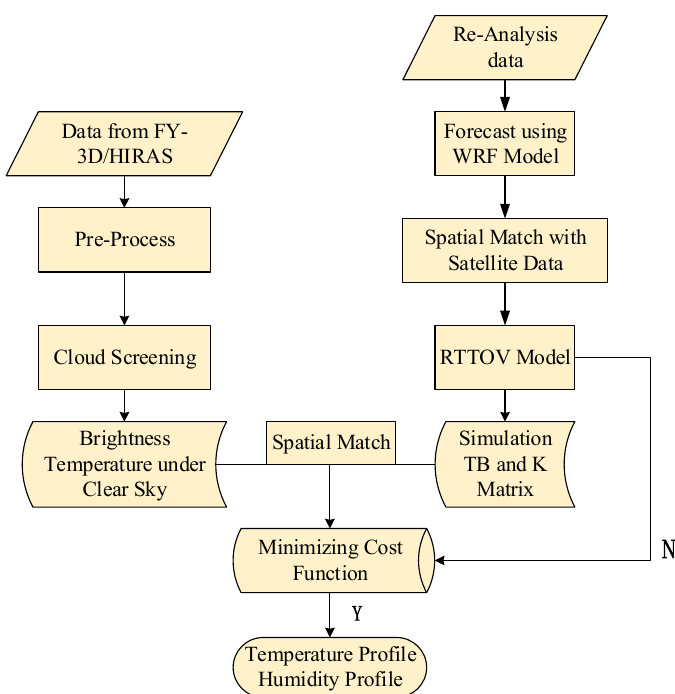
Figure 7. The general framework of the 1D-VAR assimilation method proposed herein. RTTOV: Radiative Transfer for TOVS, TB: Brightness Temperature WRF: Weather Research and Forecast